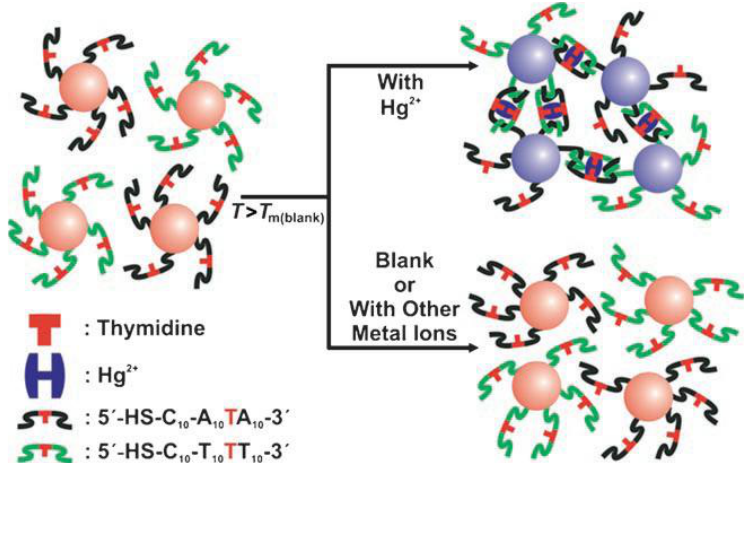
Figure 6. Colorimetric detection of Hg 2+ using DNA-Au NPs. Reprinted with permission from Ref.